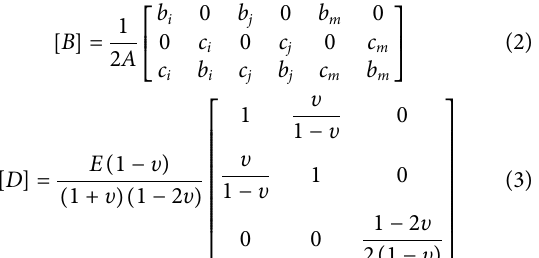
Frontiers in Earth Science |